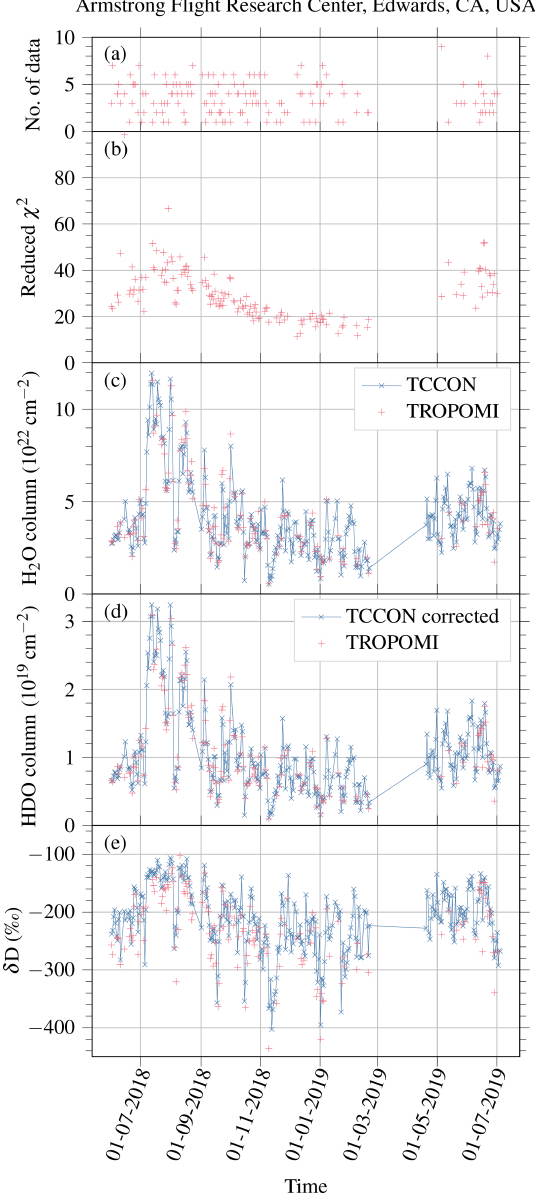
Figure 5. Time series of daily averages of corrected TCCON mea- surements (blue crosses) and co-located TROPOMI observations (red pluses) at Edwards station (35.0 ◦ N, 117.9 ◦ W, 700ma.s.l.). Shown are (a) the number of individual observations per day, (b) the reduced χ 2 , (c) the H 2 O columns, (d) the HDO columns and (e) the a posteriori δ